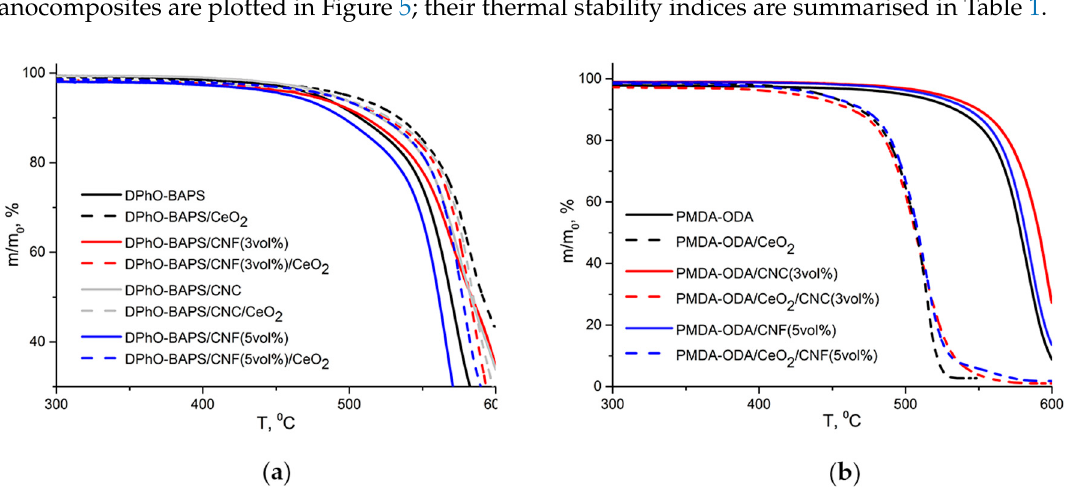
Figure 5. Analysis (TGA) curves of ( a ) DPhO-BAPS-based samples; ( b ) PMDA-ODA-based samples. Figure 5. analysis (TGA) curves of ( a ) DPhO-BAPS-based samples; ( b) PMDA-ODA-based samples. Table 1. Thermal stability indices of polyimides (PIs) and PI-based nanocomposites.